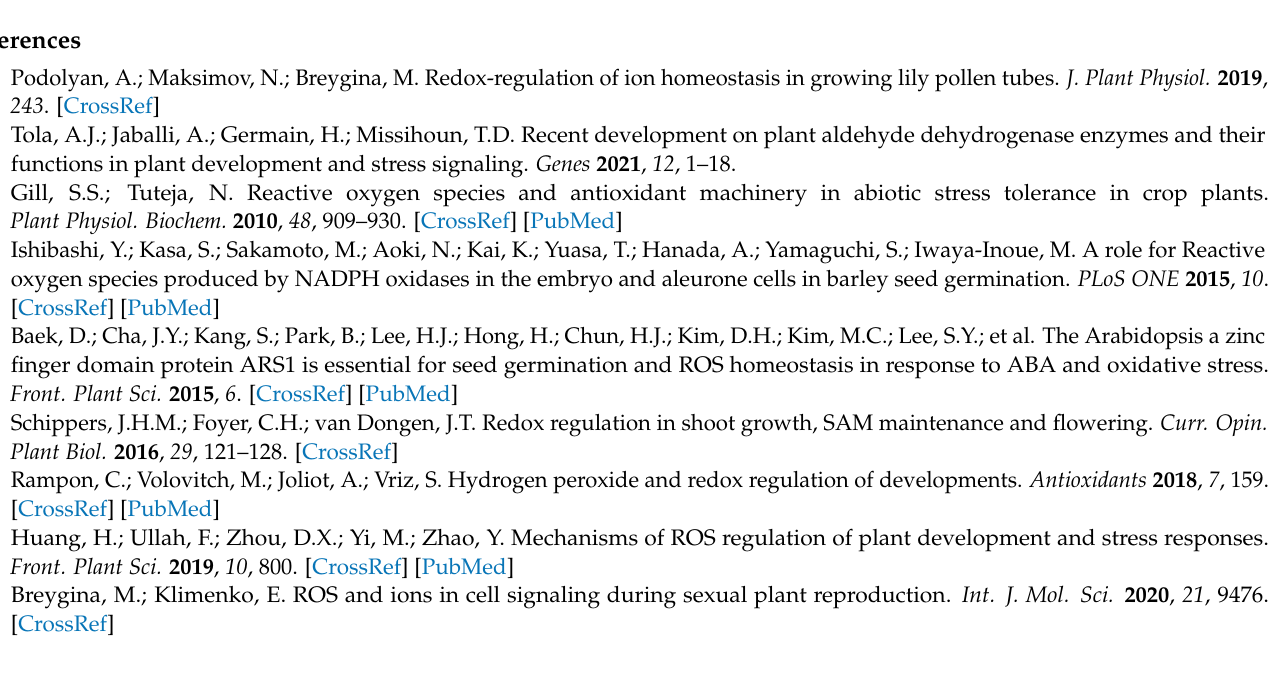
Table 2. Original data from